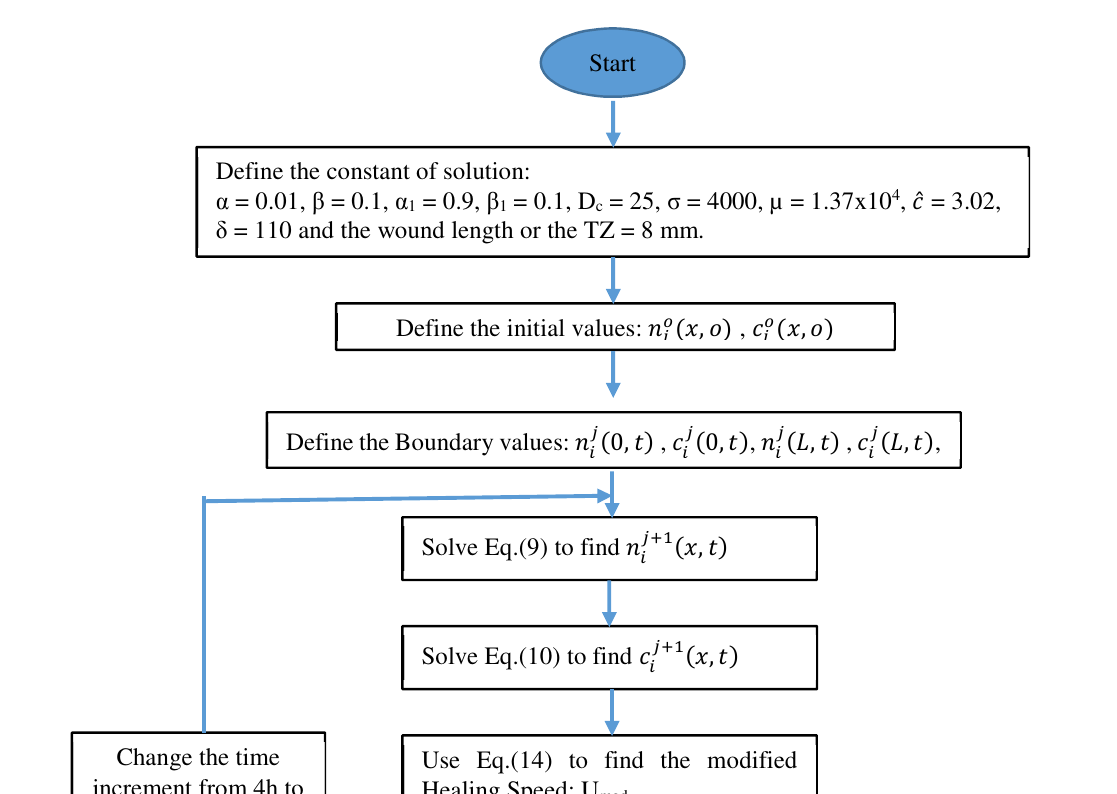
Fig. 4. Radial and tangential direction with the start and end of epithelization.